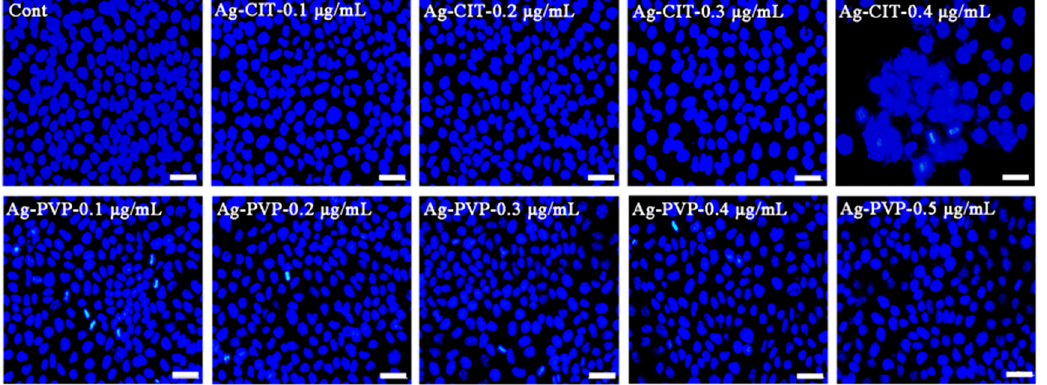
Figure 11. The representative pictures of Caco-2 cells exposed to Ag NPs for 21 days. Cells were stained with DAPI and investigated under the fluorescence microscope. Scale bar: 30 μ m.